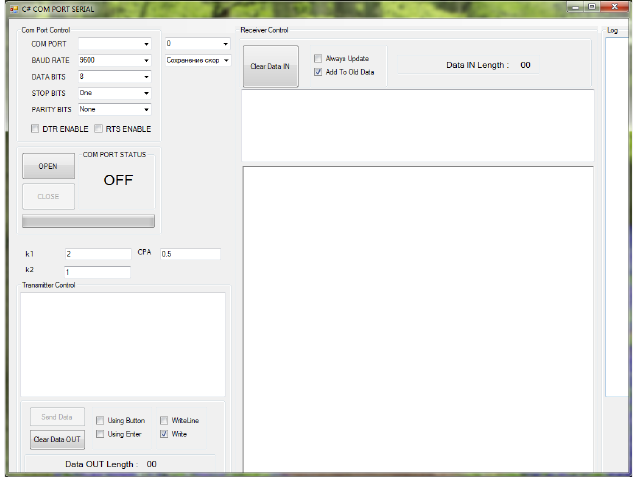
Fig. 5. Information exchange